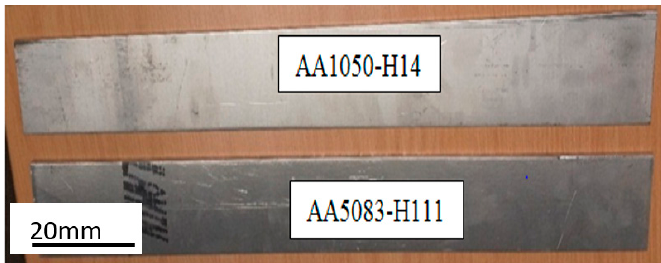
Figure 1. Aluminium alloy plates prepared for